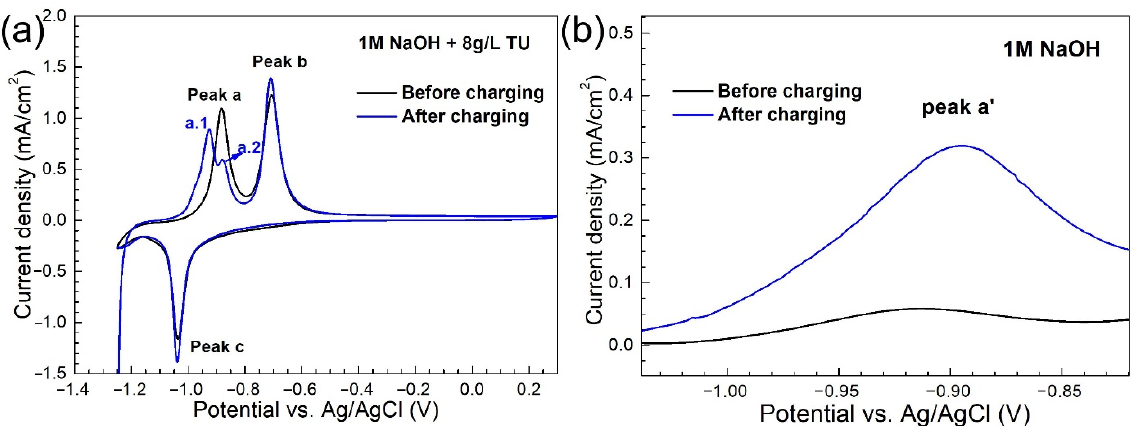
Figure 6. Cyclic voltammograms of the 690 MPa grade steel base metal obtained before and after hydrogen charging in NaOH solution with the thiourea ( a ) and without thiourea ( b ) (scan rate 10 mV/s).